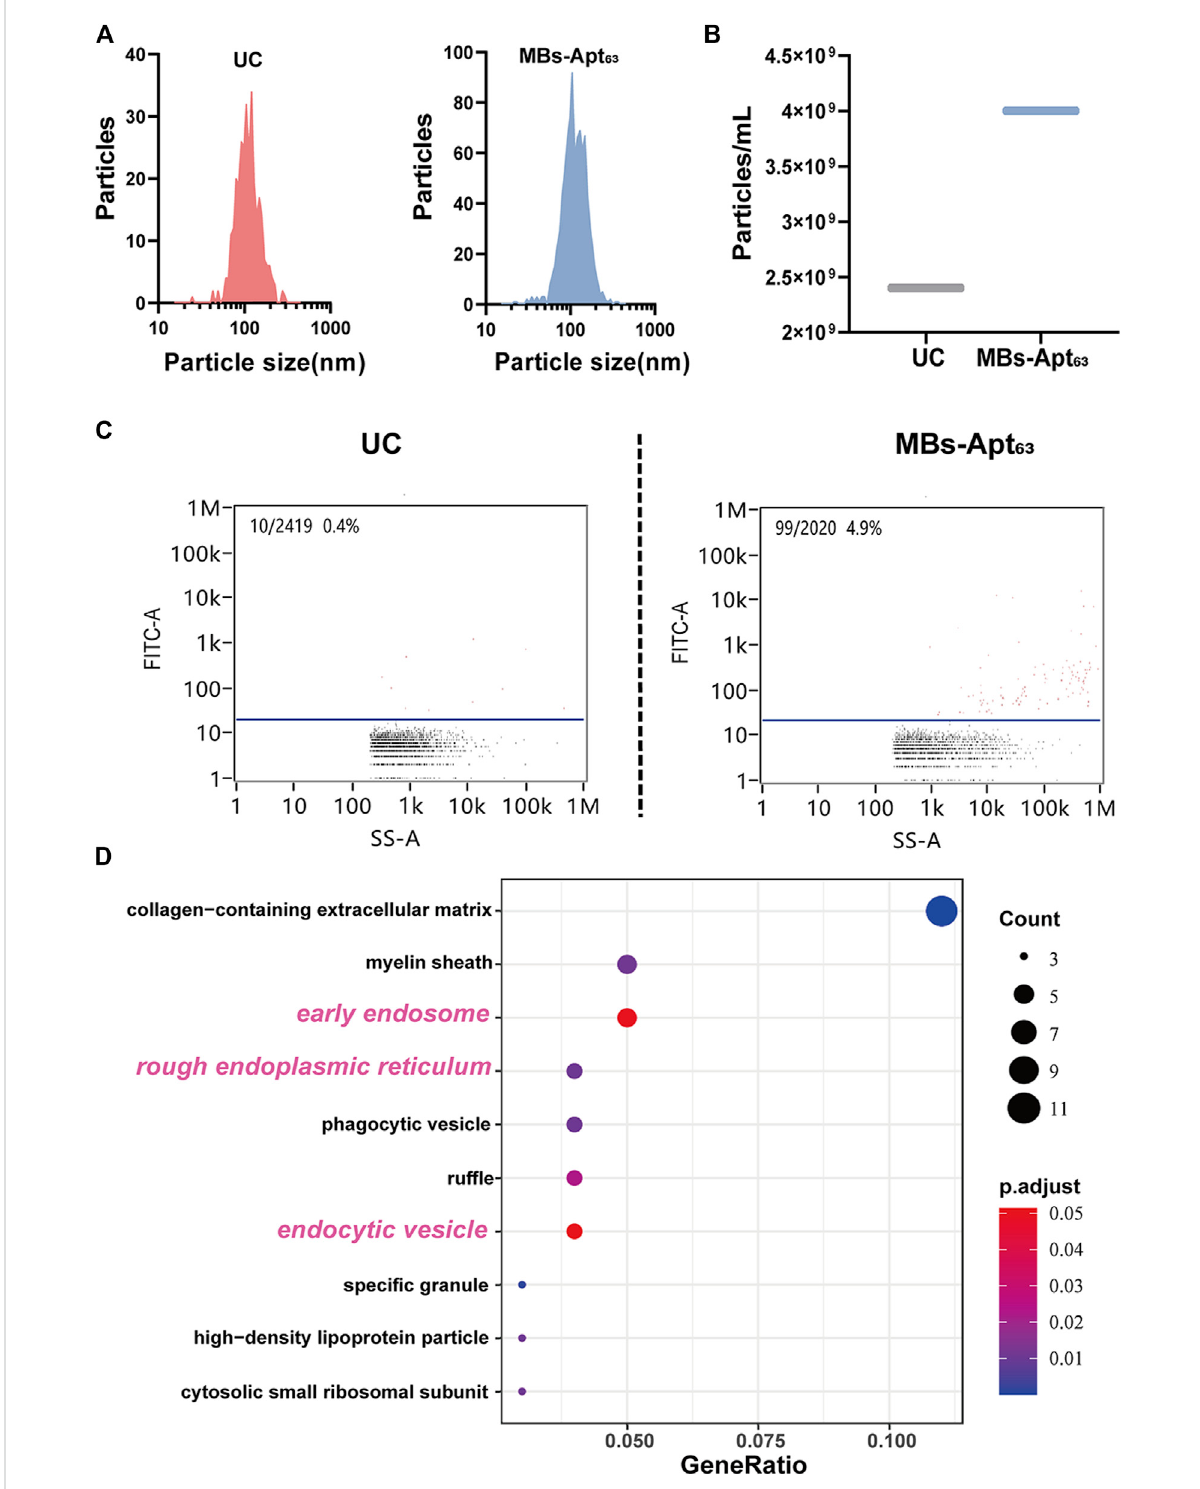
FIGURE 5 Evaluation of MBs-Apt 63 in the isolation of serum tumor exosomes. (A) Particle size distributions of exosomes extracted by UC and MBs-Apt 63 . (B) AverageserumexosomeconcentrationspreparedbyUCorMBs-Apt 63 ; (C) ExpressionabundanceofCD63inexosomesisolatedbyUCandMBs- Apt 63 . Results were obtained from nano fl ow fl ow test; (D) GO analysis of proteins from exosomes separated by MBs-Apt 63 or UC. Top 10 GO components are displayed that are most enriched in exosomes separated by MBs-Apt 63 ( p < 0.05 as signi fi